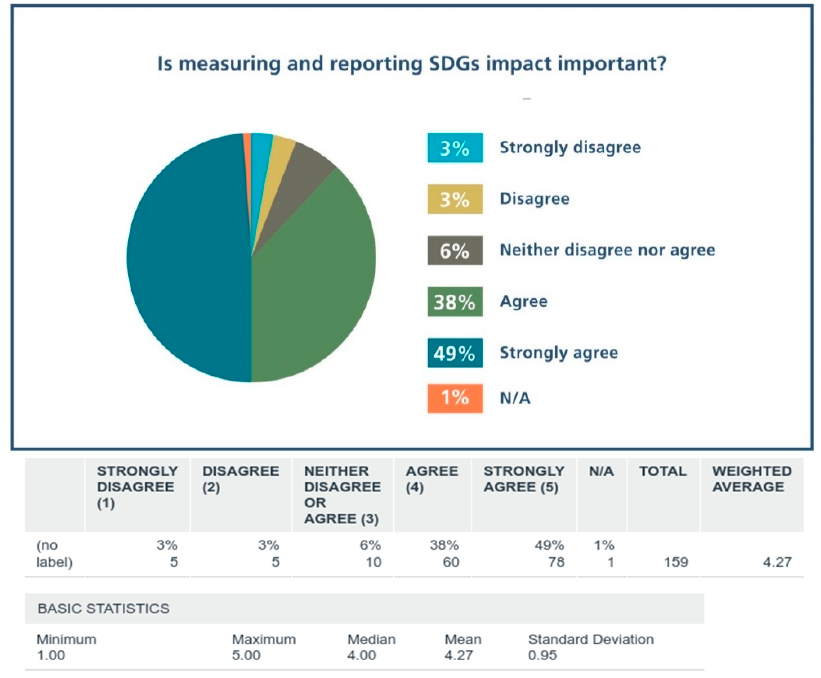
Figure 7. Response to Question 1: Should engineering businesses seek ways to measure and report SDG impact?